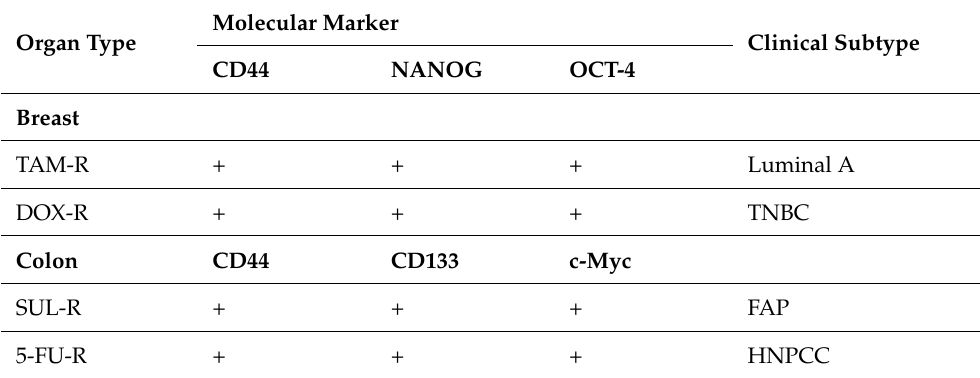
Table 5. Marker expression in breast and colon cancer stem cell models.